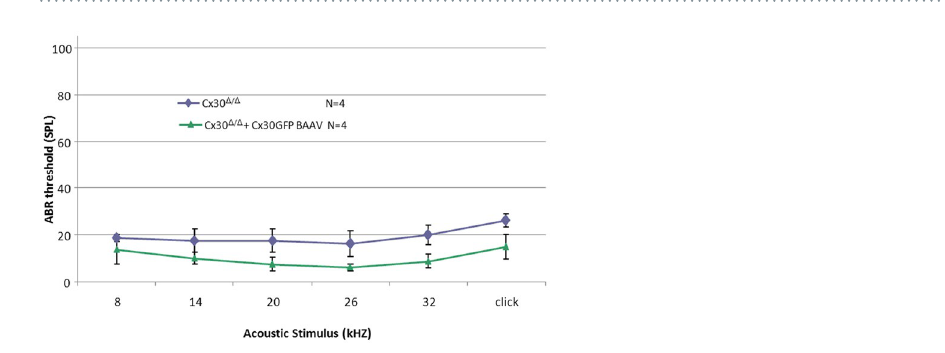
Figure 4. Hearing thresholds determined by analysis of auditory brainstem responses (ABR) in mice injected with BAAVCre–IRESGFP and their respective controls. Error bars represent s.e.m.